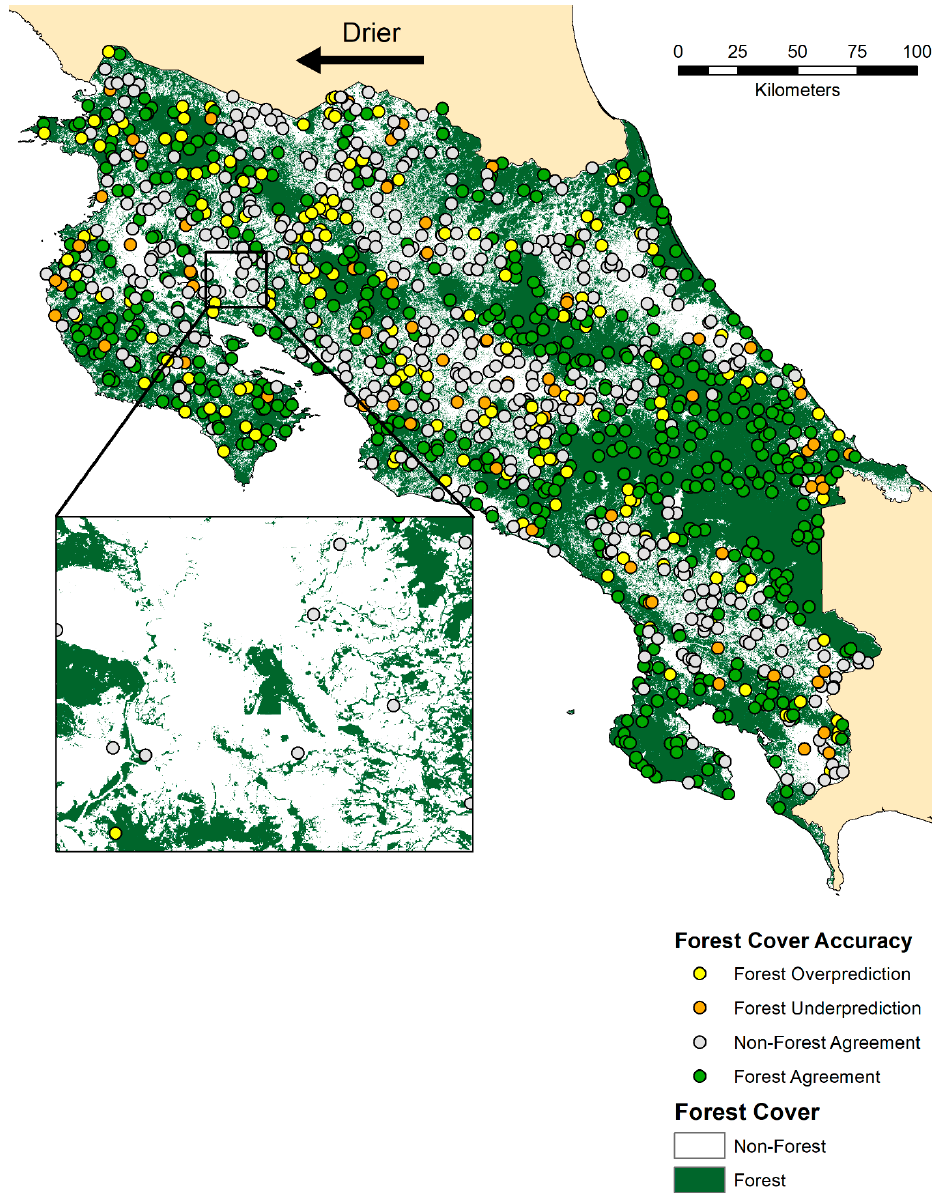
Figure 6. Landa regional tree cover, showing the spatial distribution of forest cover errors when compared to reference data in Costa Rica ( n = 1154). Because the Landa forest cover is a binary forest/non-forest classification, an 89% tree cover threshold was applied to the reference dataset. The colored points reflect the confusion matrix errors, visualized on the map.